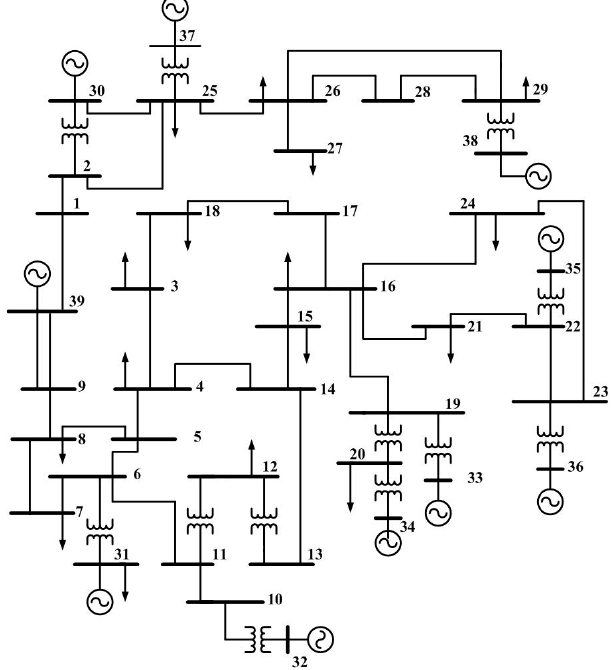
Figure 5. Single Line Diagram of the System IEEE 39-Bus Reliability Test.